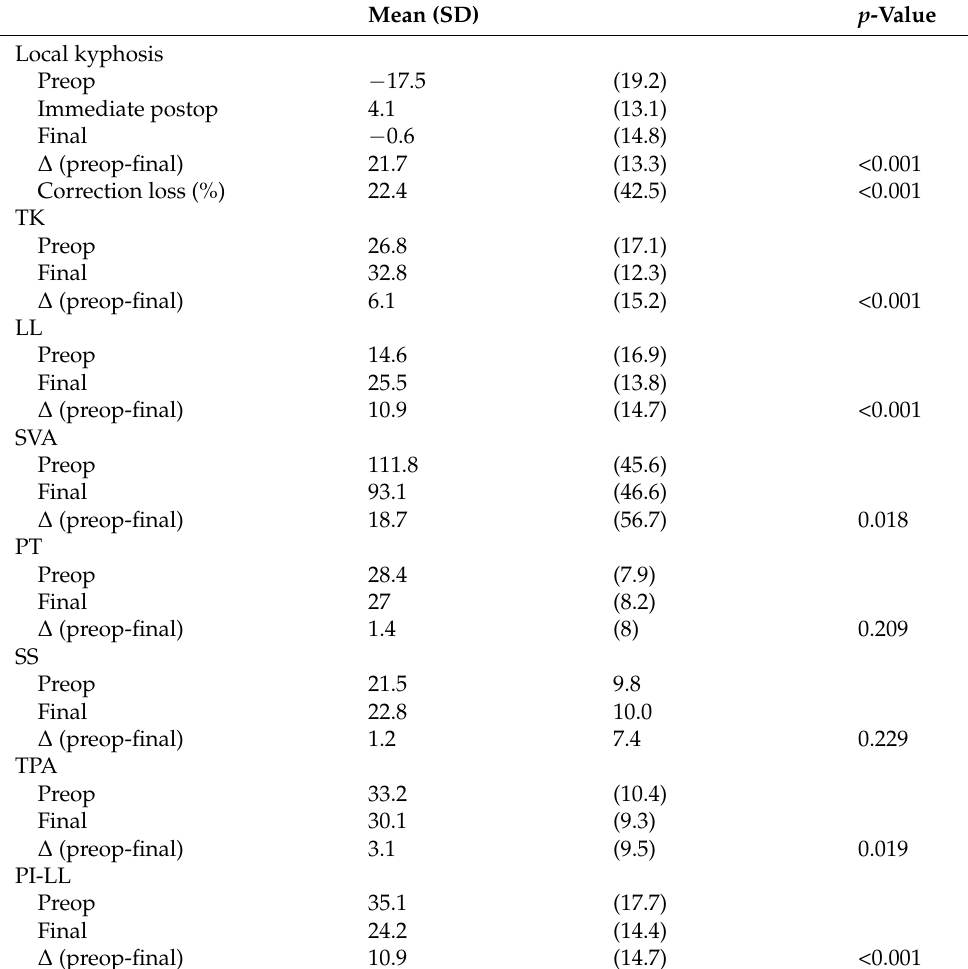
Table 1. Comparison of local and global alignment pre- and